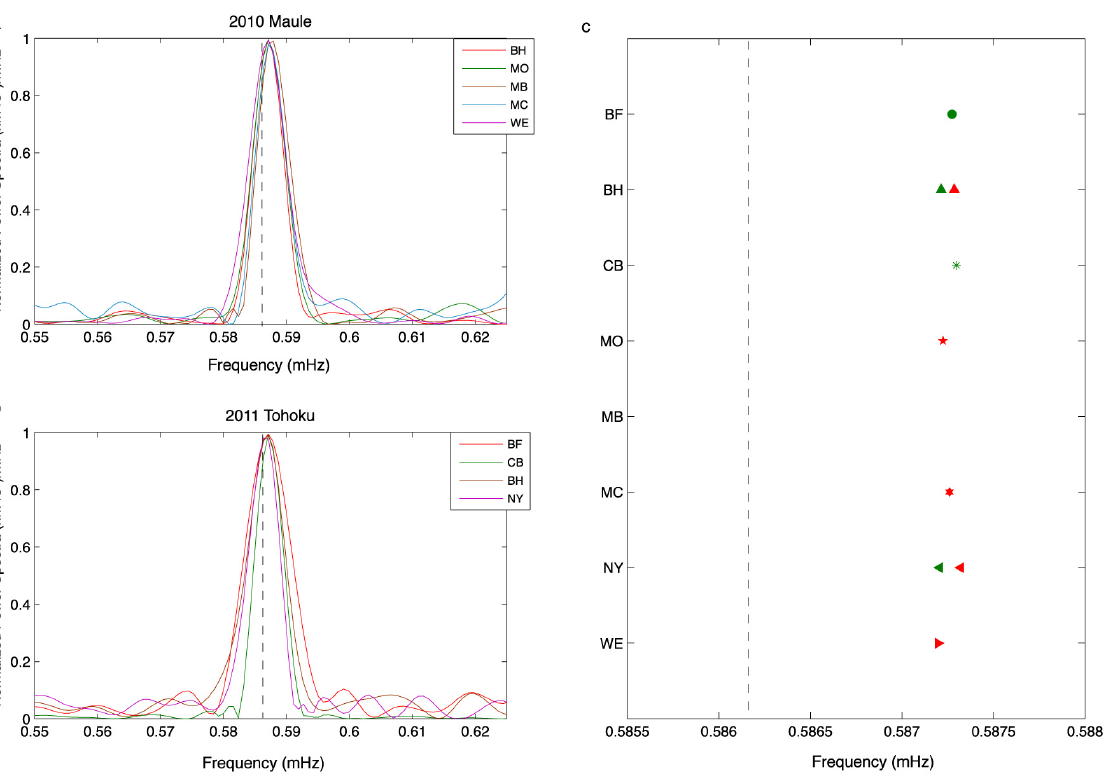
T based on the residual gravity time series after the 2010 and 2011 events. (a) The results of 5 residual grav- Figure 9. The power spectra of 0 3 ity time series after the 2010 Maule event; (b) the results of 4 residual gravity time series after the 2011 Tohoku; (c) the estimated frequen- cies from different series. The PREM prediction is denoted by the vertical dashed line. The red symbols indicate the results obtained from the 2010 event, and the green symbols indicate the results obtained from the 2011